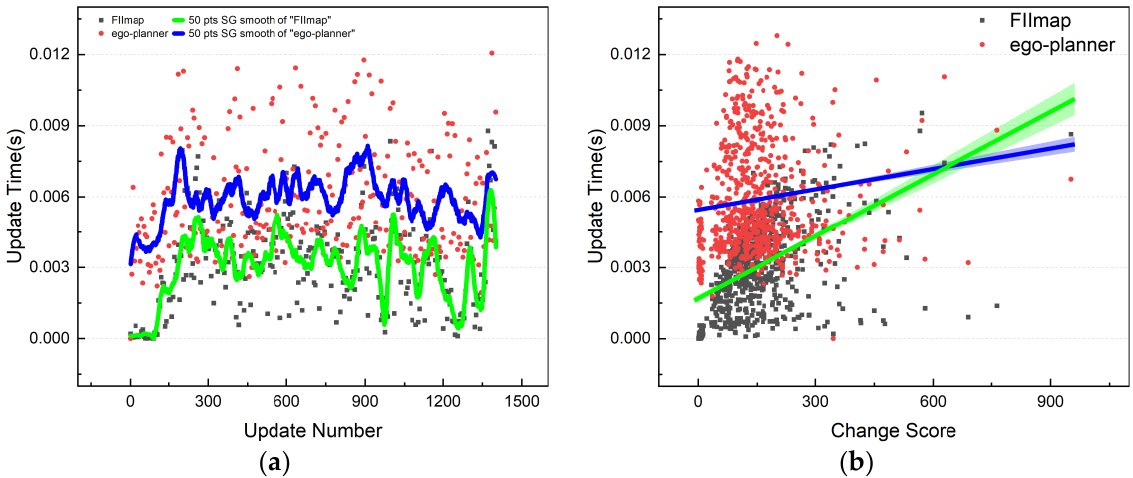
Figure 7. Comparison on the Cow_and_Lady dataset. The resolution is 0.2 m and the inflated size is single voxel resolution. The update number axis means the time axis. ( a ) The time consumption with update number. ( b ) The time consumption with change